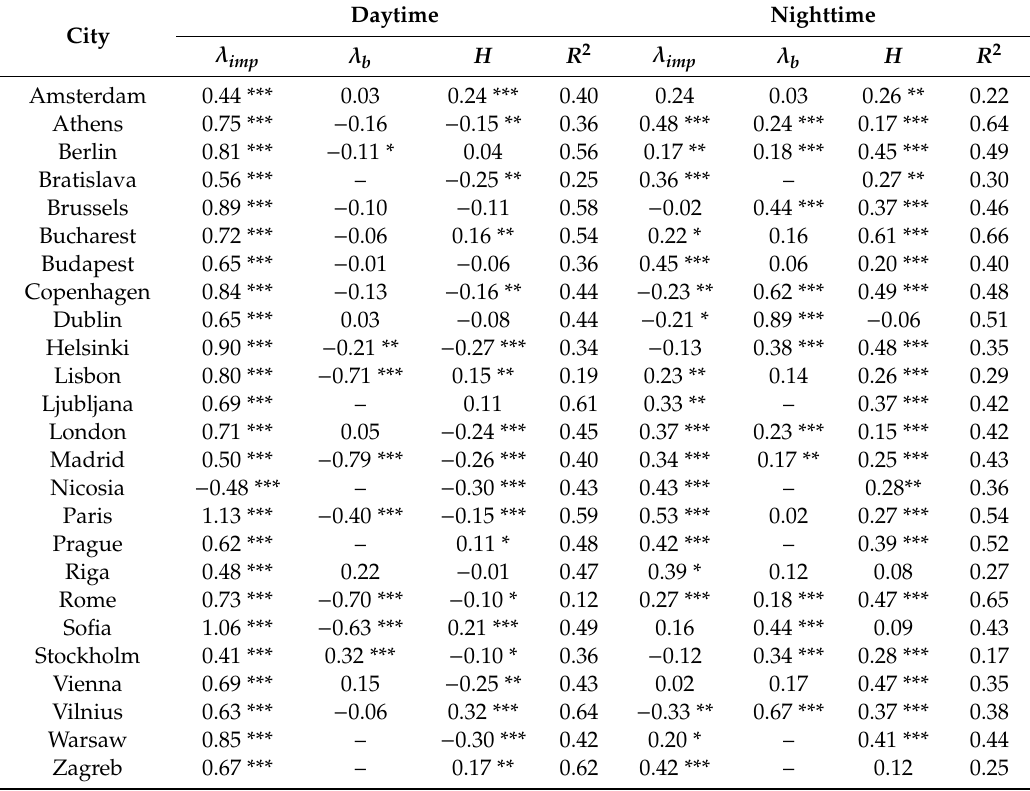
Table 6. Standardized regression coe ffi cients and coe ffi cient of determination R 2 for the multiple regression models between the urban surface parameters and